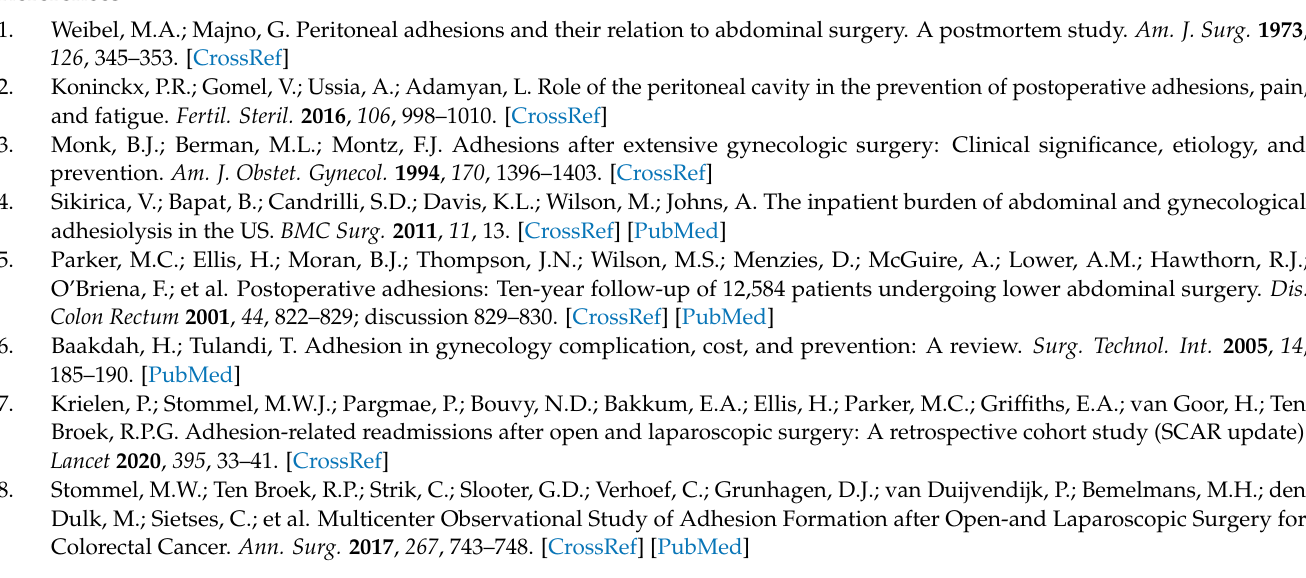
Table S1: Severity of Adhesions as Determined During Second